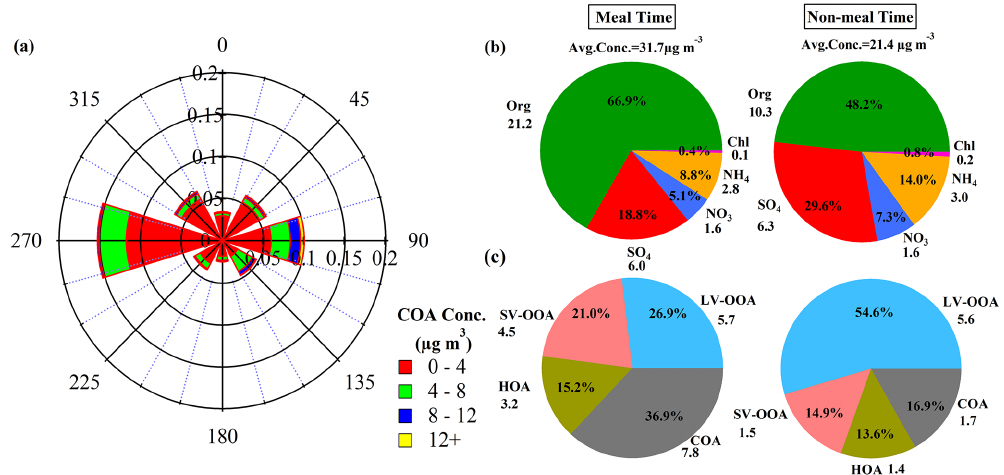
Figure 6. (a) Wind rose plot of COA concentration. The angle and radius present the wind direction and its probability, respectively, while color indicates COA concentration. (b) The fractional composition of NR-PM 1 species during mealtime (12:00–02:00, 19:00–21:00) and non-mealtime (00:00–06:00). (c) The fractional composition of OA during mealtime and non-mealtime.